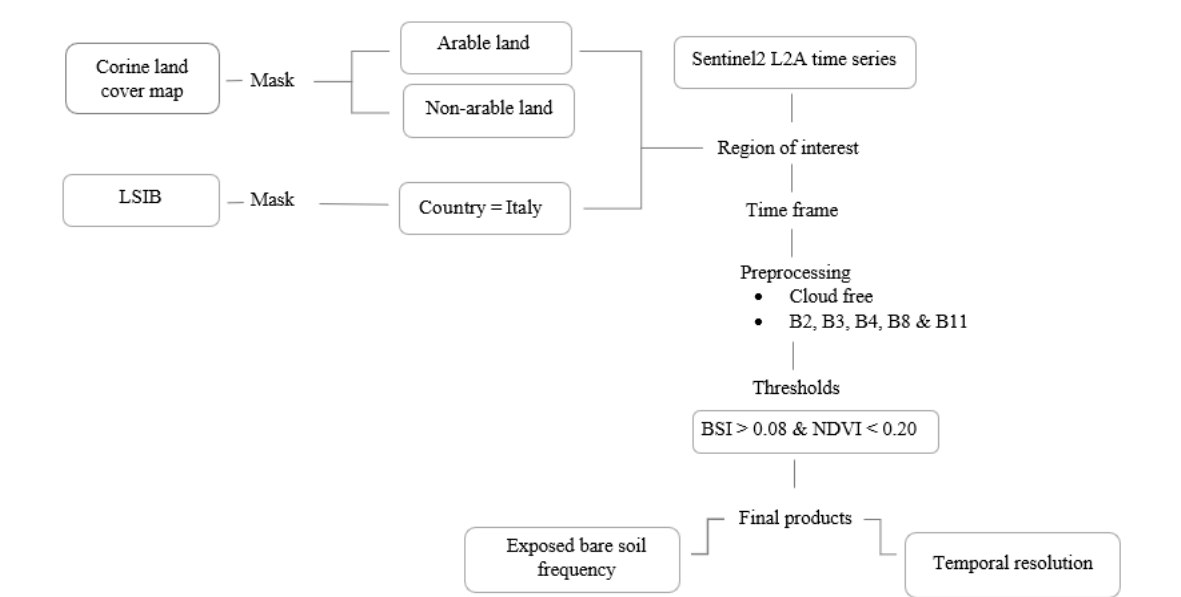
Figure 2. Flowchart of the methodology implemented in Google Earth Engine. LSIB: Large Scale International Boundary Polygons.